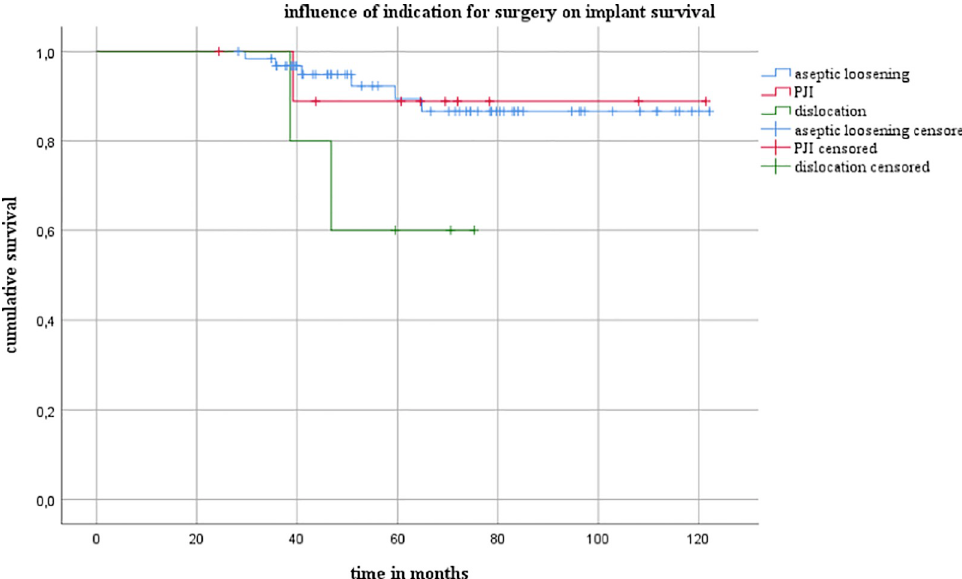
Fig 3. Influence of the indication for surgery on implant